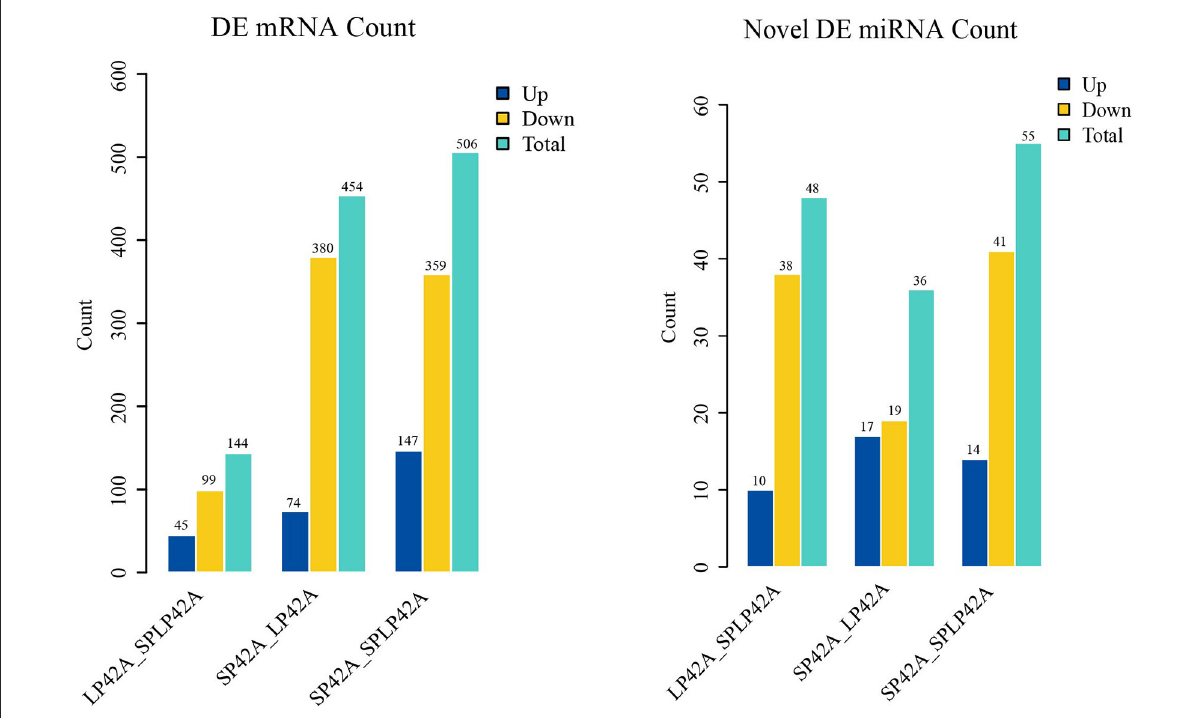
FIGURE4 Differentially expressed (DEM) microRNA and (DEG) mRNA analysis. Different color rectangles were used to represent the numbers of upregulated (blue), downregulated (yellow) and total (green) differential